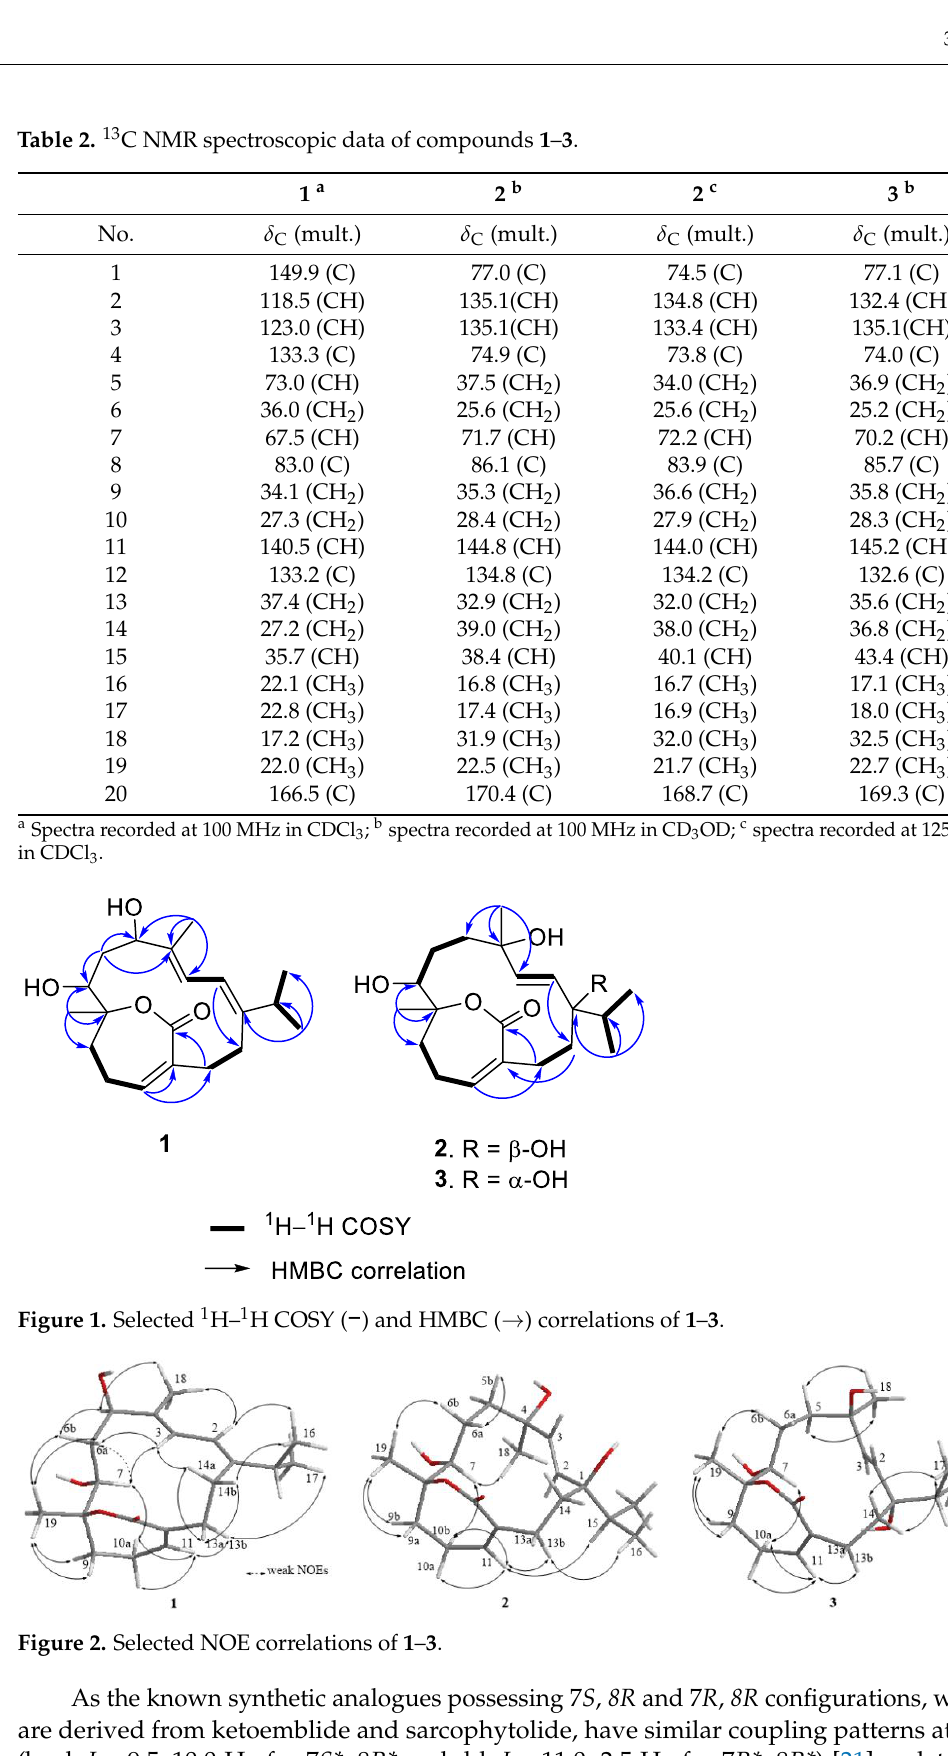
Figure 3. Low-energy conformers, populations, and dihedral angles ( ф 1 (H7-C7-C6-H6 pro-S ) and ф 2 (H7-C7-C6-H6 pro-R )) of 7 S * ,8 R * - 1 at CAM-B3LYP/6-31+G(d,p) IEFPCM (CHCl 3 ) level of theory.